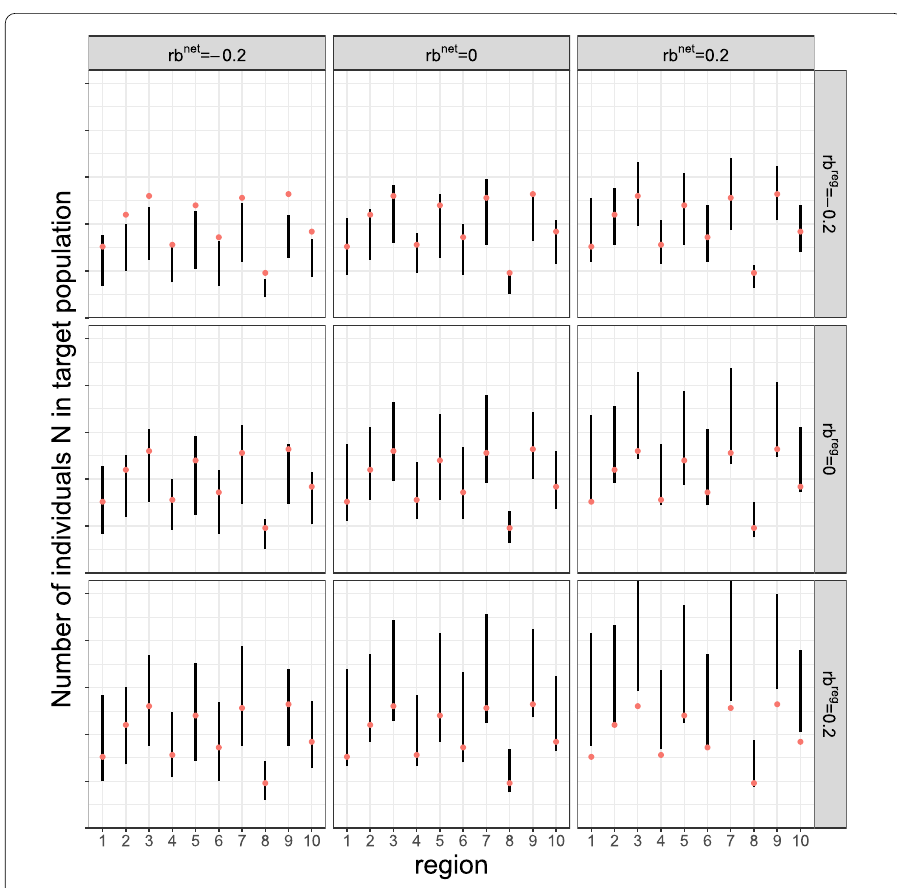
Figure 15 Credible intervals for the initial number of individuals N 0 per region. Credible intervals (prob = 95%) for the initial number of individuals N 0 per region compared to true values (in red) computed according to the distribution in eq. (28) with the RSS geolocation model and uniform prior and different values of rb net and rb